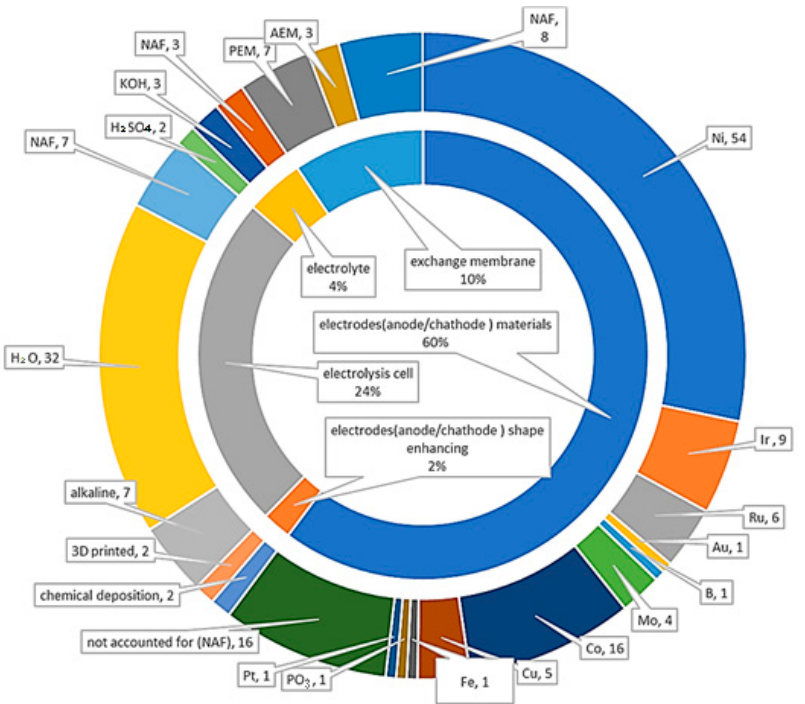
Figure 4. Pie chart showing the research area distribution.